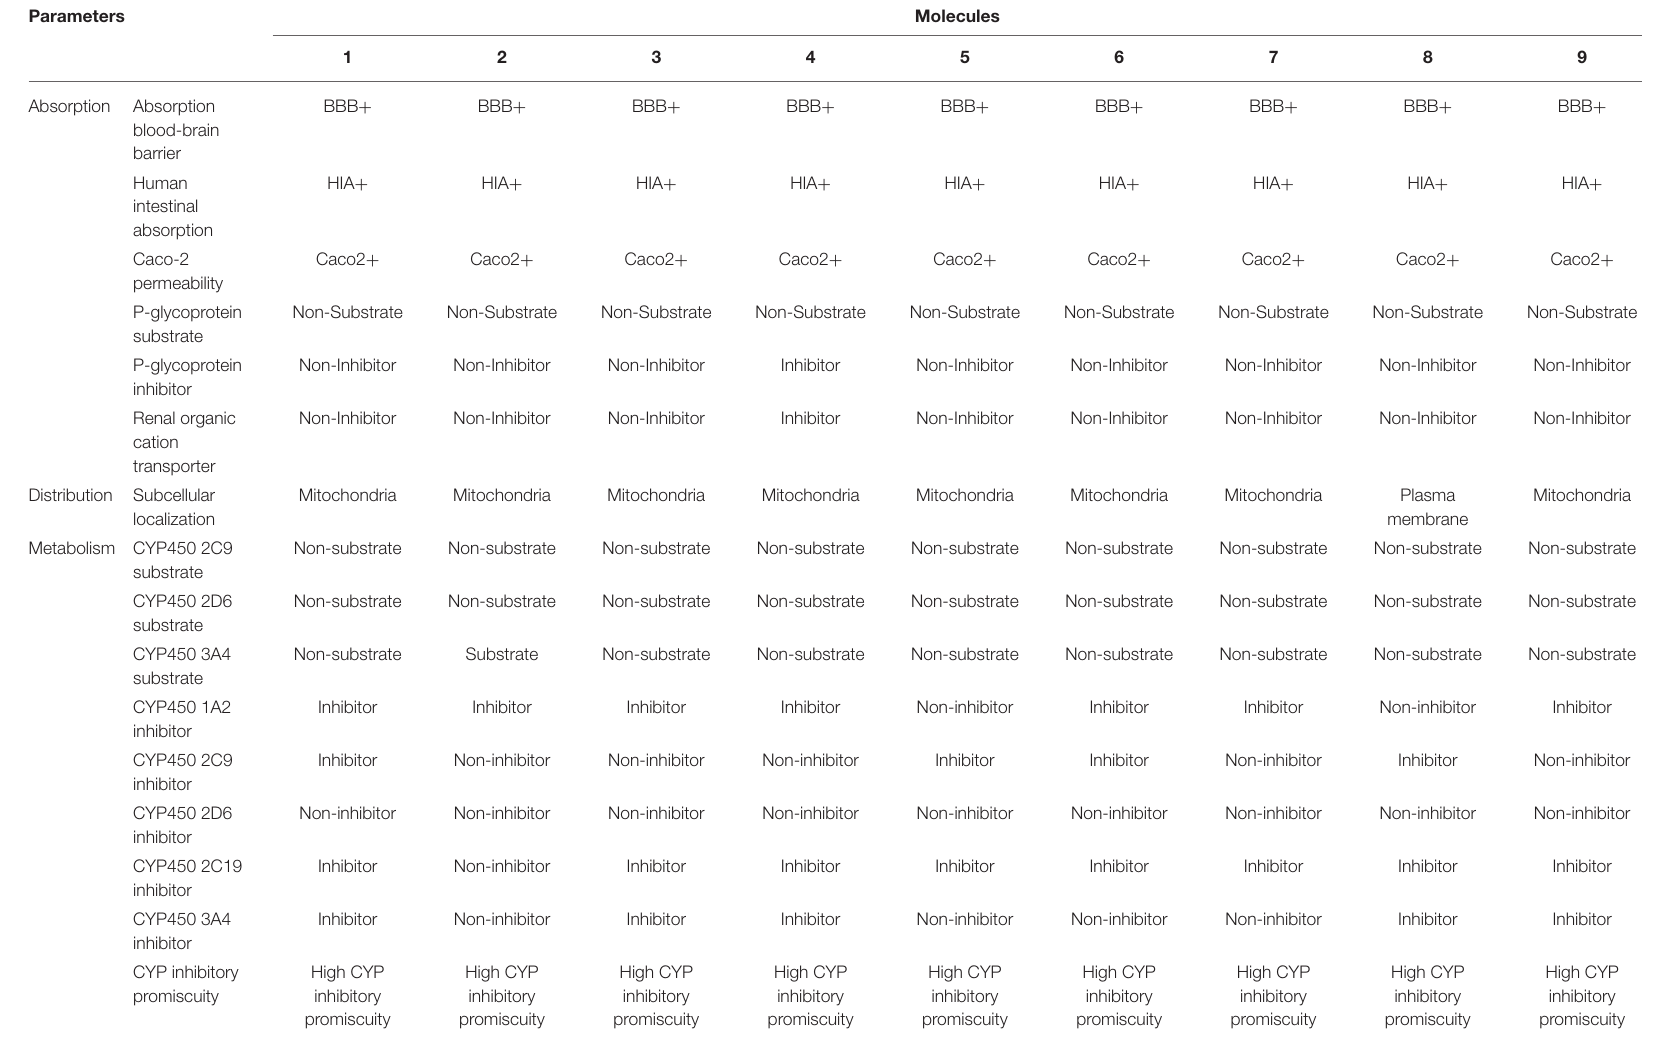
TABLE 3 | Absorption, distribution, and metabolism of the nine molecules according to admetSAR online toolkit.